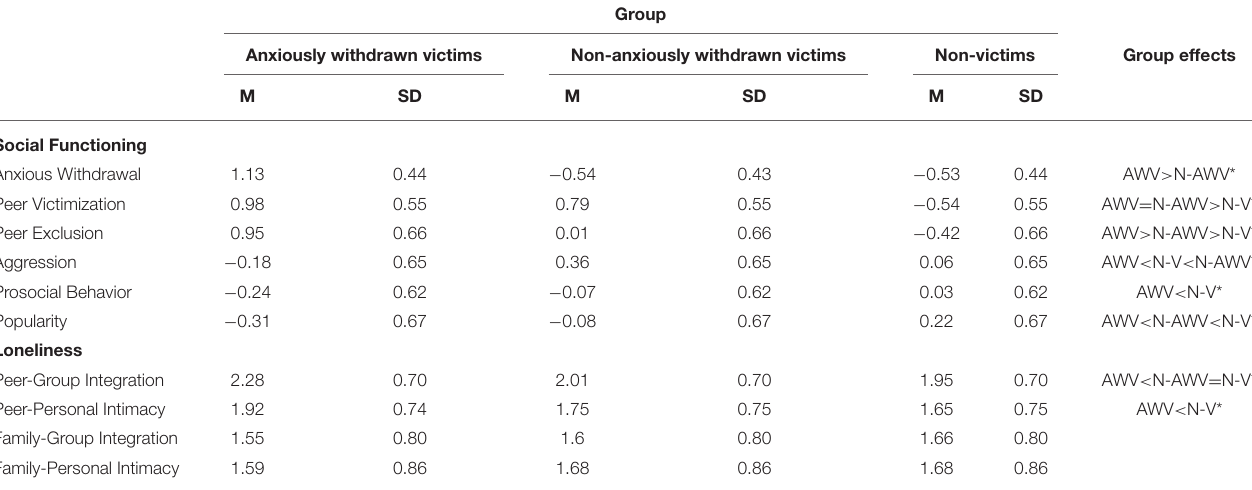
TABLE 2 | Means and standard deviations for all dimensions of social functioning and perceived feelings of loneliness, by group. Group Anxiously withdrawn